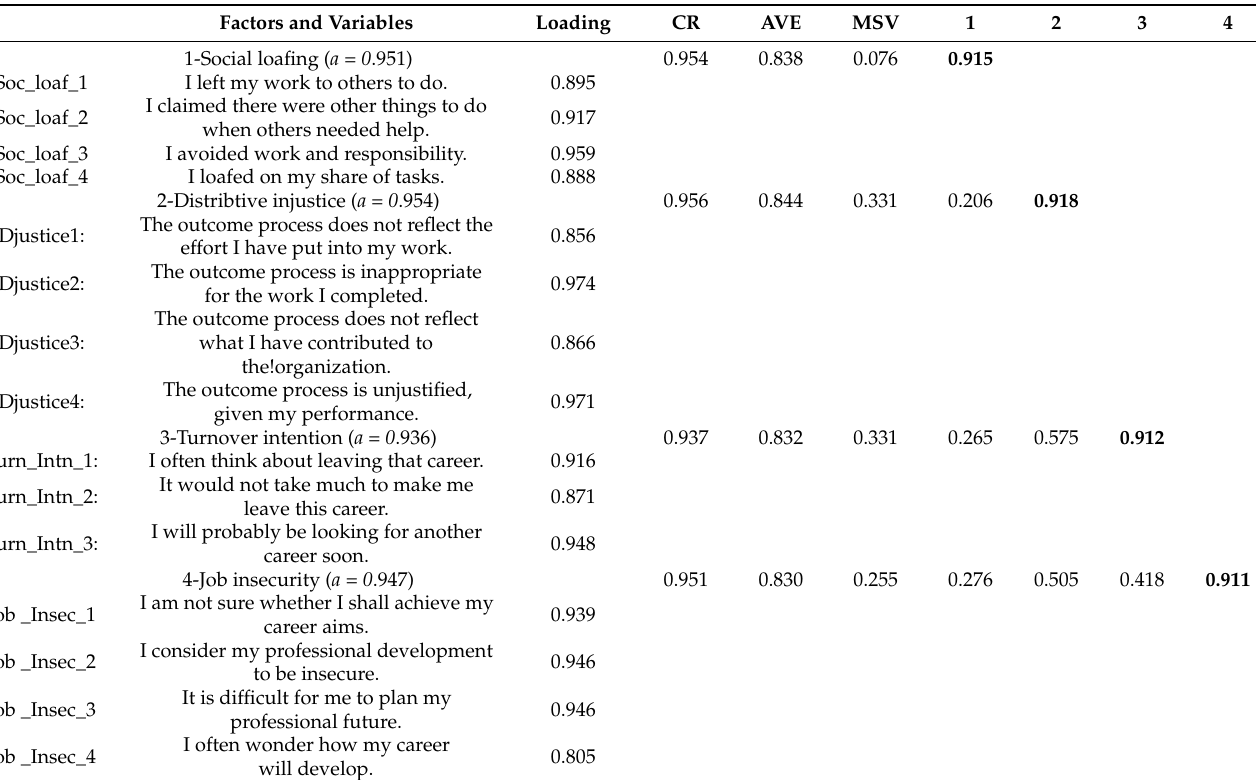
Table 2. Convergent and discriminant